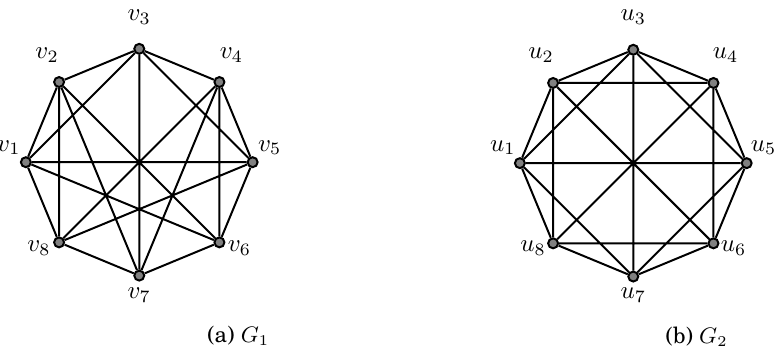
Figure 8: Regular graphs of same order with different upper domatic numbers.